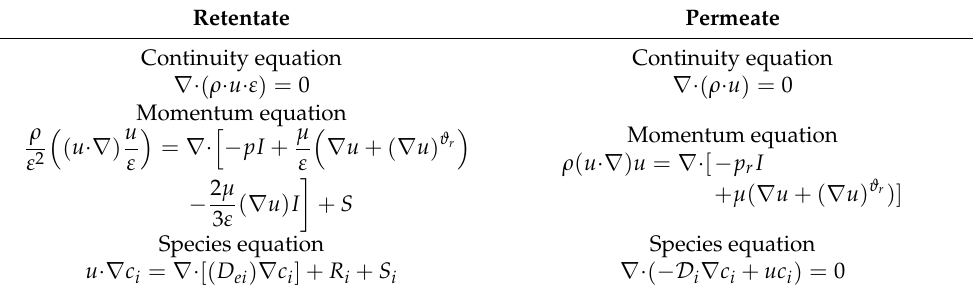
Table 1. Governing equations in the CFD